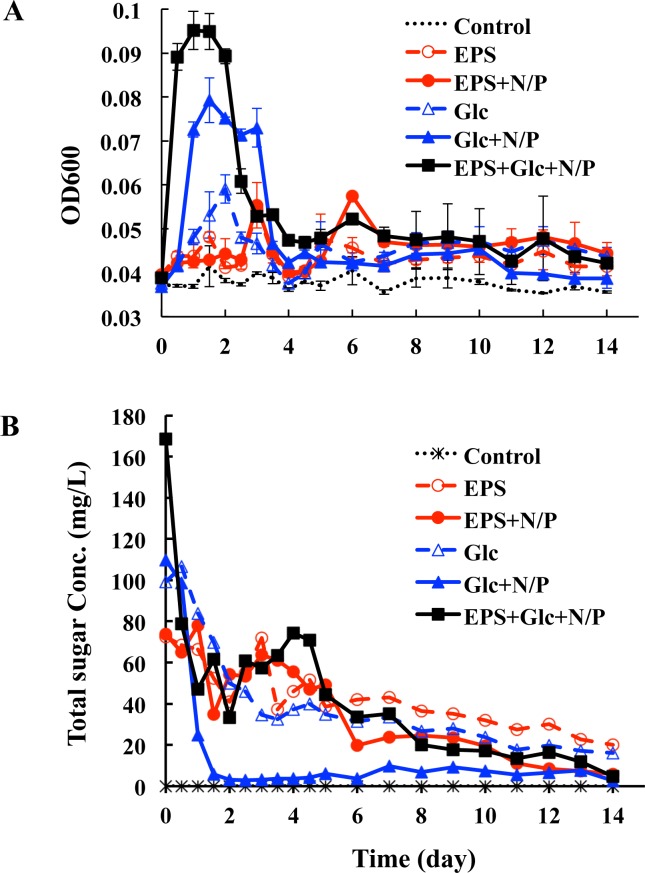
Effect of EPS and Glc on the microbial growth in seawater.(A) Growth curves. (B) Consumption of sugar during microbial cultivation.